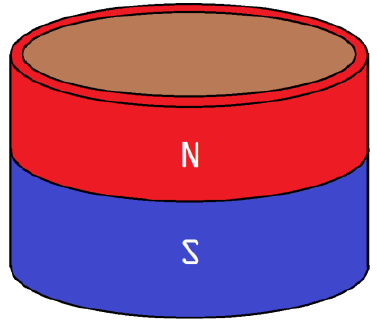
part with a simulated flaw.